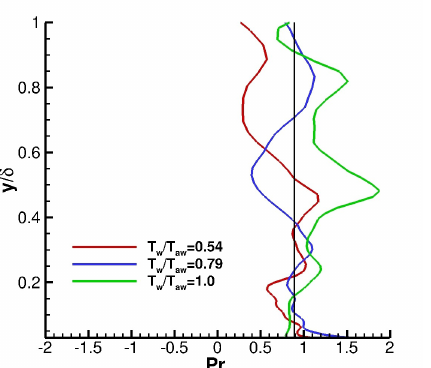
Figure 13. Effect of wall temperature on turbulent Prandtl number.